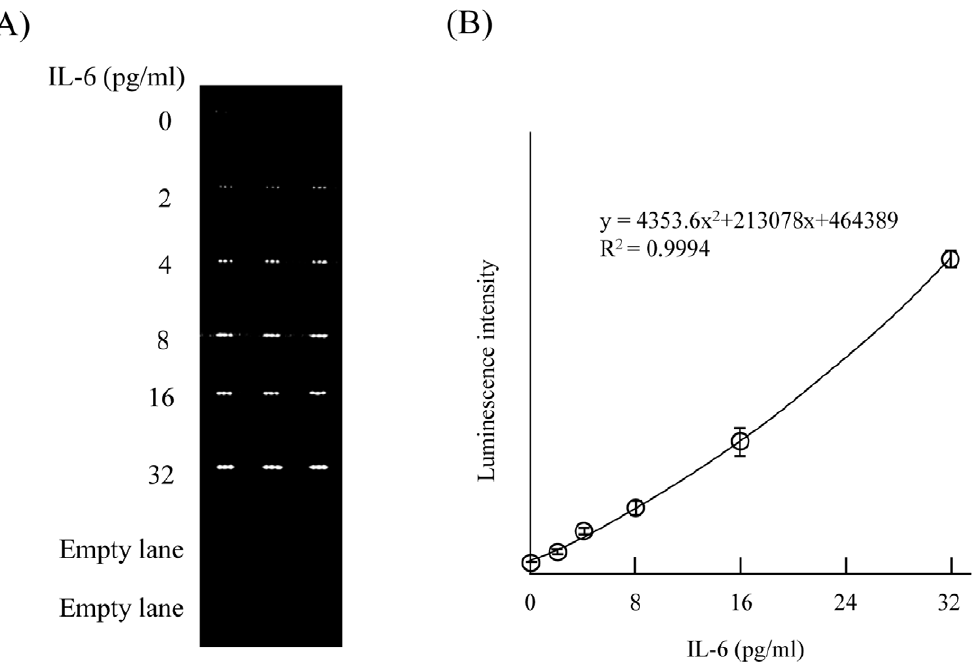
Figure 2. Detection of purified IL-6 by sandwich ELISA on a microchip. Three deposits of 1st antibody were made into each microchannel, and 0 to 32 pg/ml IL-6, biotin-conjugated 2nd antibody, avidin-conjugated HRP solution were then infused, allowing triplicate determinations to be made in one channel. (A) The luminescence increased in an IL-6 concentration-dependent manner. (B) Standard curve for the IL-6 concentration versus luminescence intensity obtained by the assay.